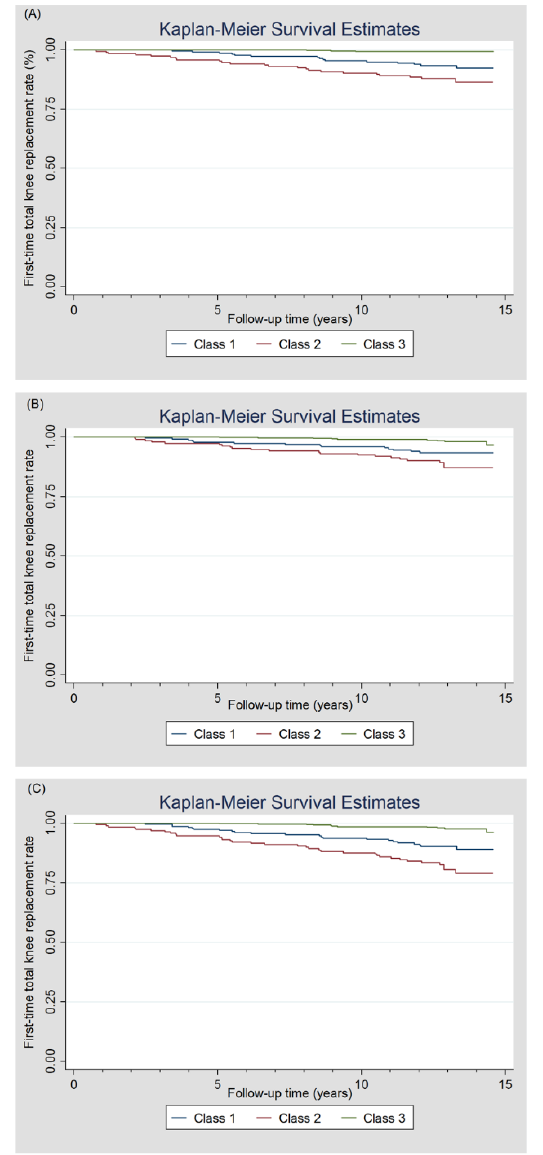
Figure 2. The first-time total knee replacement rate was plotted by a Kaplan–Meier curve over a mean observation period of 12.0 years. ( A ) right knee; ( B ) left knee; ( C ) any knee.